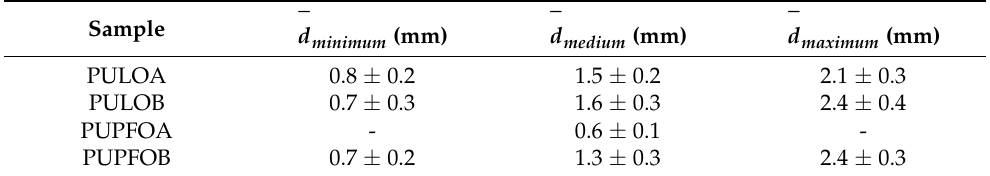
Figure 6. Stereomicroscope images of PU before soil degradation: ( a ) PULOA, ( b ) PULOB, ( c ) PUP- FOA, and ( d ) PUPFOB. Table 1. Data on minimum, medium, and maximum pore diameters of the PU surfaces stereomicro- scope images by treatment with Axiovision